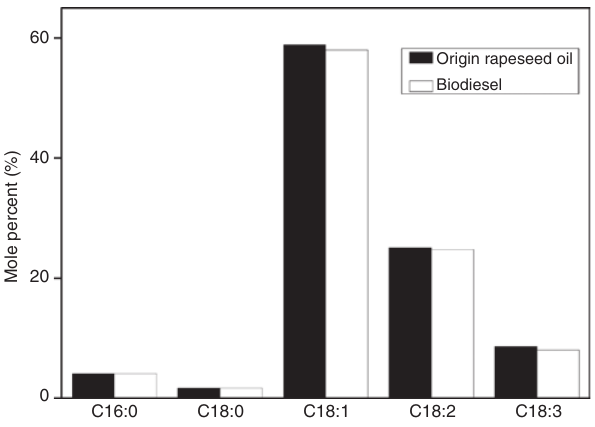
Figure 5: Ethyl ester compositions in origin rapeseed oil and bio- diesel at reaction conditions: temperature 340 ° C, molar ratio 42/1, and 30